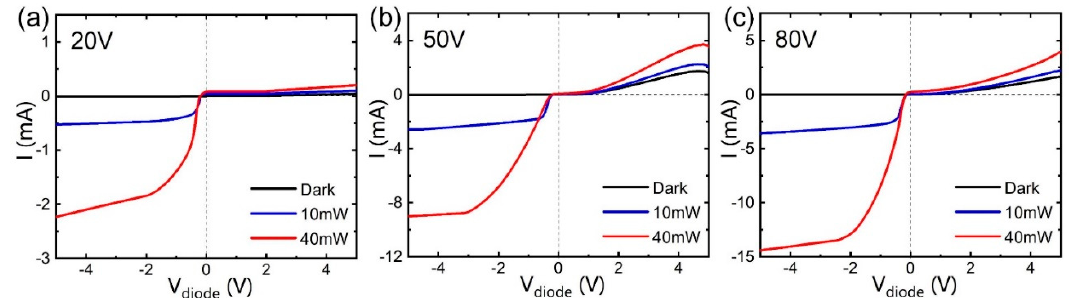
Figure 3. Current–voltage (I– V diode ) curves under darkness and illumination (P = 10 or 40 mW) of 785 nm laser of carbon films/n-Si with a V dep at ( a ) 20 V, ( b ) 50 V, and ( c ) 80 V. The GNEC film/n-Si exhibits a large photocurrent under reverse V diode . As the reverse bias voltage increases from 0 to − 2 ~ − 3 V, the photocurrent tends to saturate.